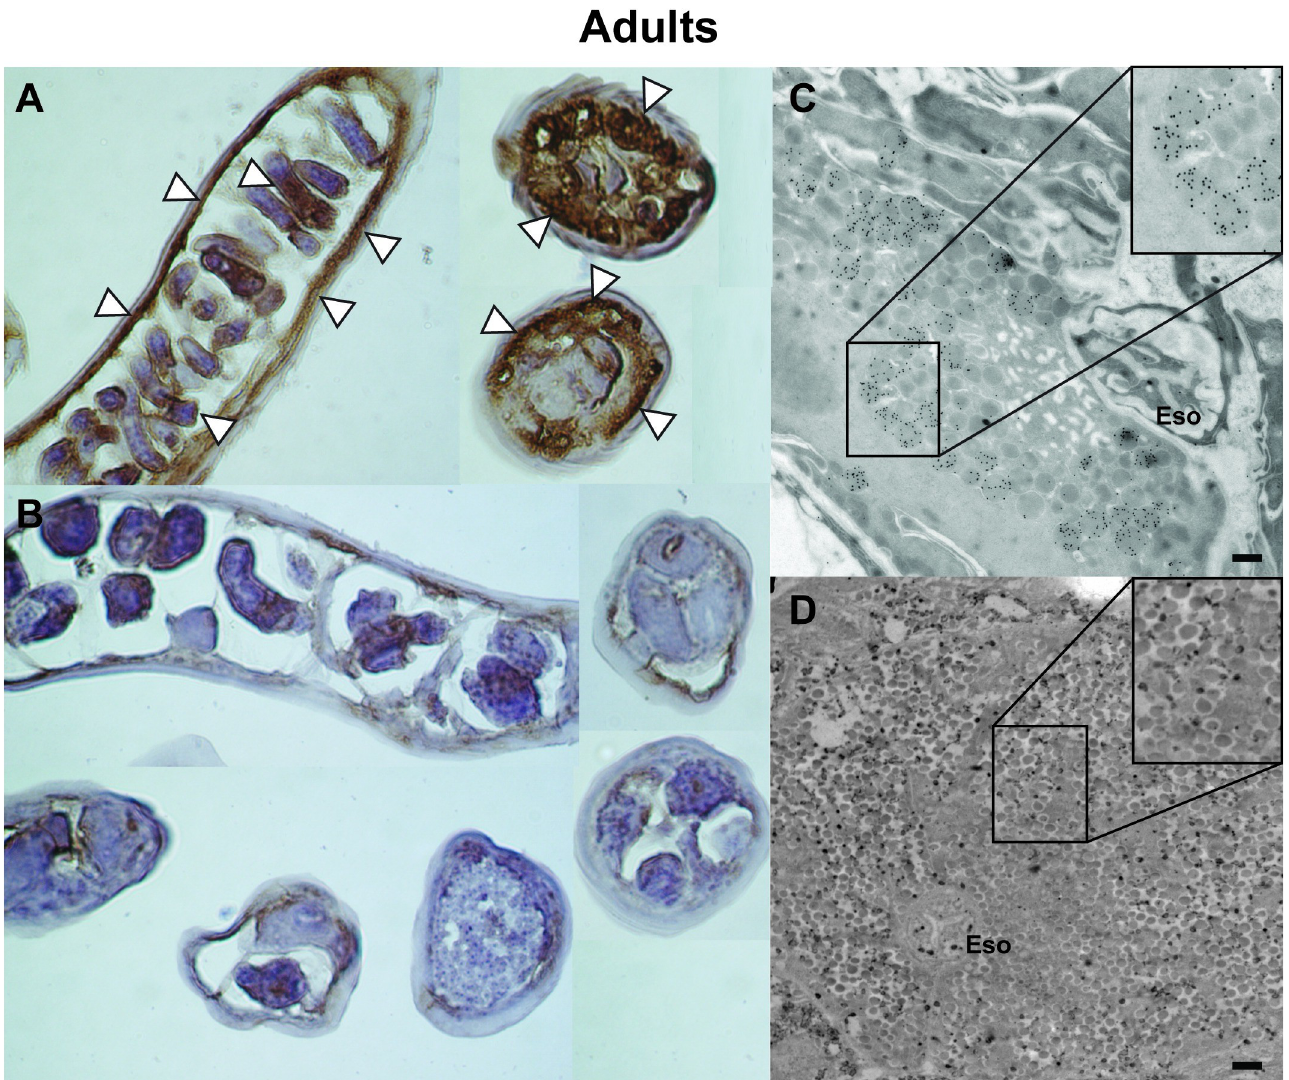
Fig 5. Histochemical and ultrastructural localization of SML-4 in adult nematodes. (A and B) Formalin-fixed paraffin embedded T . spiralis adults probed with anti-SML-4 (A) or pre-vaccination control sera (B) and detected with HRP-conjugated anti-IgG and DAB substrate. Sections were counterstained with Mayer’s hematoxylin. The white arrows show areas of staining within specific regions of the adult stichocytes and the uterine wall. (C and D) TEM sections of T . spiralis adults were probed with anti-SML-4 (C) or pre-vaccination control sera (D) and visualized with goat anti-mouse IgG coupled to 15 nm gold particles (black dots). Localization of SML-4 to granules adjacent to the esophagus can be observed. Eso: Esophagus. Black scale bars five hundred nm are shown in image C and